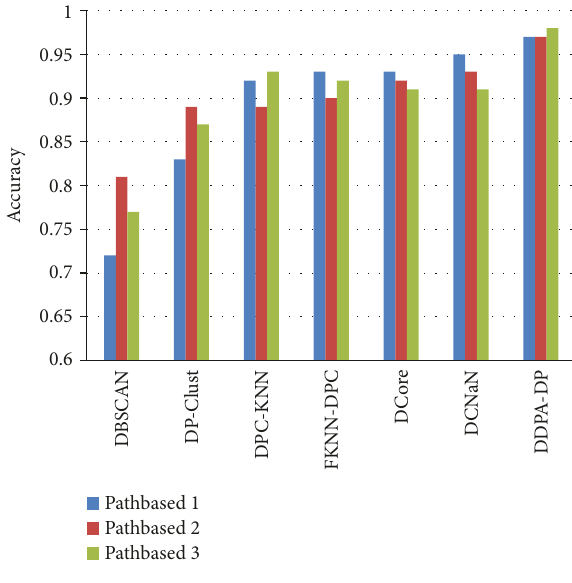
Figure 17: The simulation results in Pathbased.